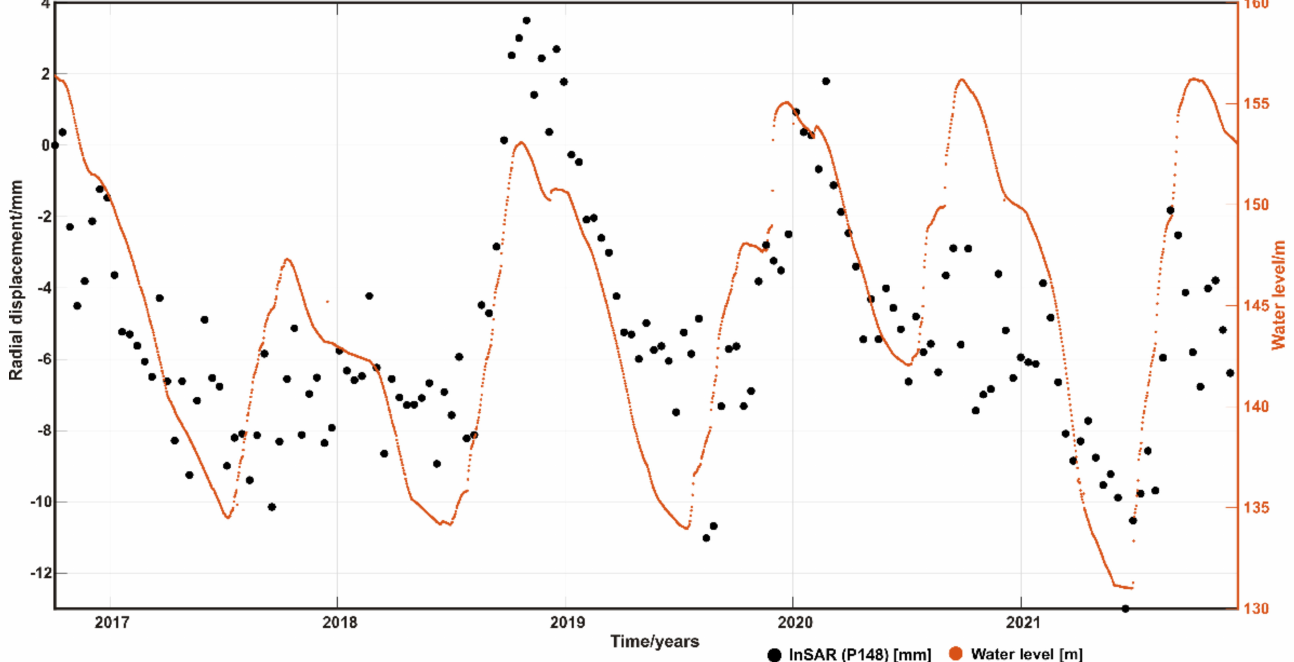
Figure 8. Comparison between the radial displacements from MT-InSAR measurements at PS no. 148, located at the center of the crest, and the water level of the Sanalona